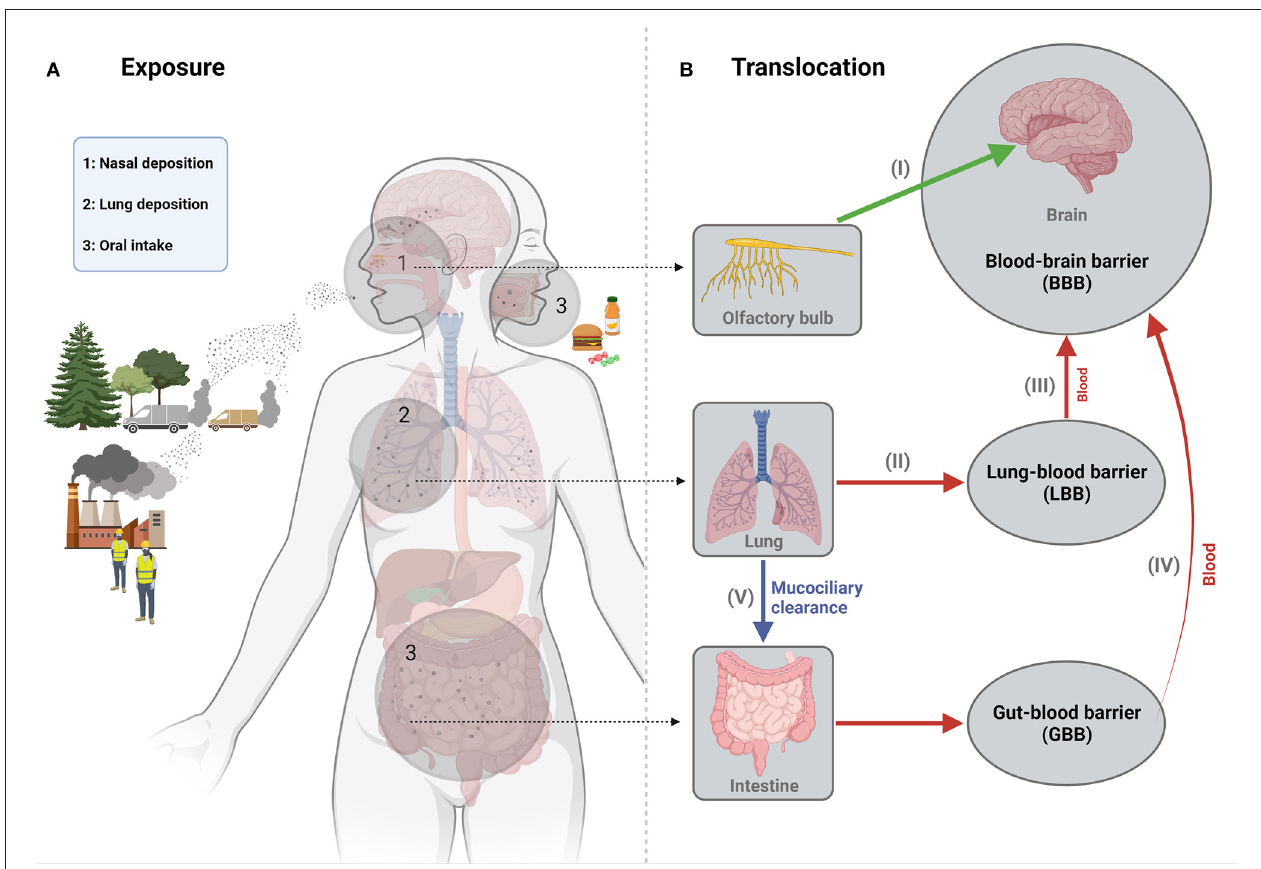
FIGURE 1 | Schematic representation of the main exposure (A) and translocation (B) routes of engineered nanomaterials in relation to their potential neurotoxicity. Concerns about the neurotoxicity of nanoparticles via inhalation exposure exist in particular for UFP originating from combustion processes at transport-dominated locations. Inhalation represents the most important occupational exposure route for ENM, during their manufacturing or further processing. The most relevant pathway of translocation to the brain for such inhaled particles involves their uptake and retrograde transport along the olfactory nerve upon deposition in the nasal cavity (I). UFP and ENM deposited in the lower respiratory tract can also translocate from this region into the bloodstream upon crossing the “lung-blood barrier (LBB)” (II) and a subset of these particles may thus enter the brain parenchyma across the blood-brain barrier (III). In non-occupational settings, the oral exposure route is particularly relevant for ENM, which may be present in food as additives or contaminants. Uptake across the intestinal mucosal barrier into the bloodstream (IV) of these ENM may thus also result in translocation into the brain. This pathway should also be considered for the fraction of inhaled small particles that is swallowed upon lung mucociliary clearance (V). Depending on exposure levels and their physicochemical properties, accumulation of ENM in the brain may thus directly affect brain structures and cells. However, neurotoxicity and neurological disturbances may also proceed in an indirect manner, for instance, driven by inflammatory effects of inhaled or ingested ENM at the organ of entrance or by ENM induced gut microbiome dyshomeostasis. Figure created with